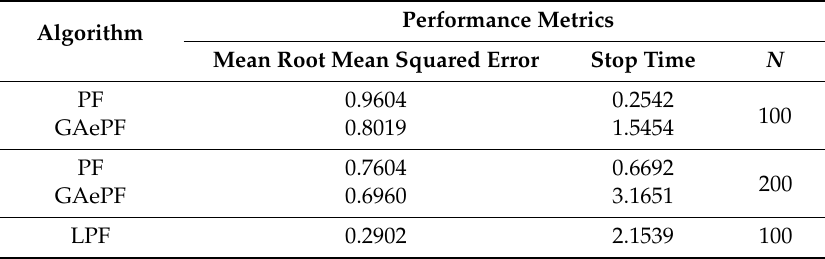
Table 1. Mean Root Mean Squared Error and Stop Time.